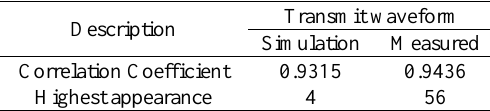
Table 5. Effect of Transmit Waveforms on Simulation Results